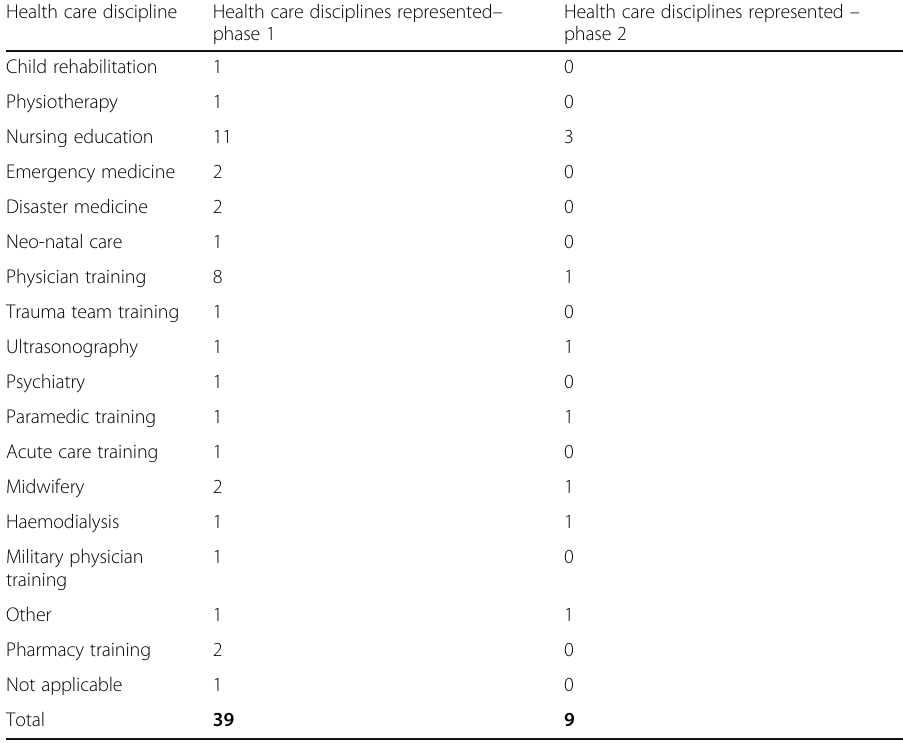
Table 2 Health care disciplines represented Health care discipline Health care disciplines represented – phase 1